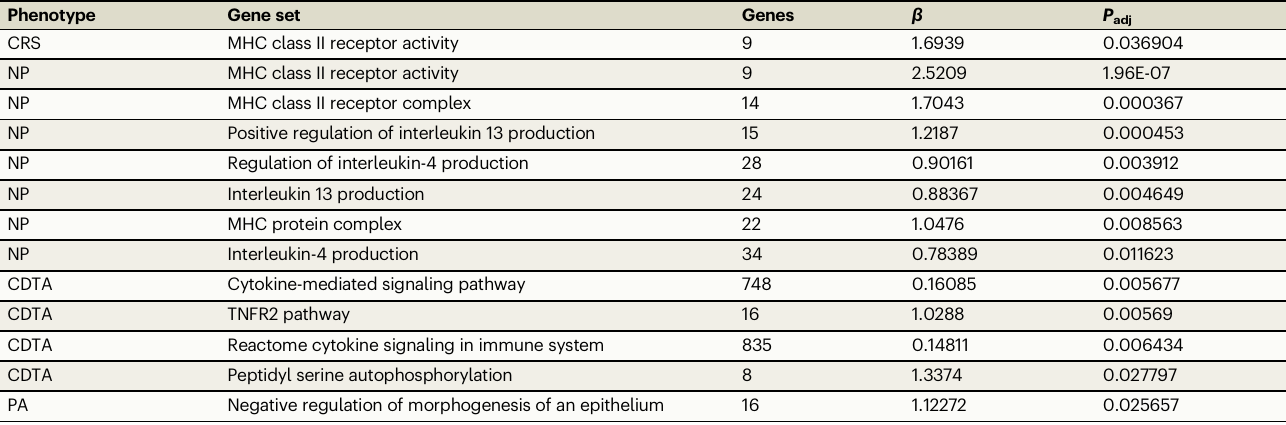
Table 5 | Gene sets enriched in MAGMA analyses Phenotype